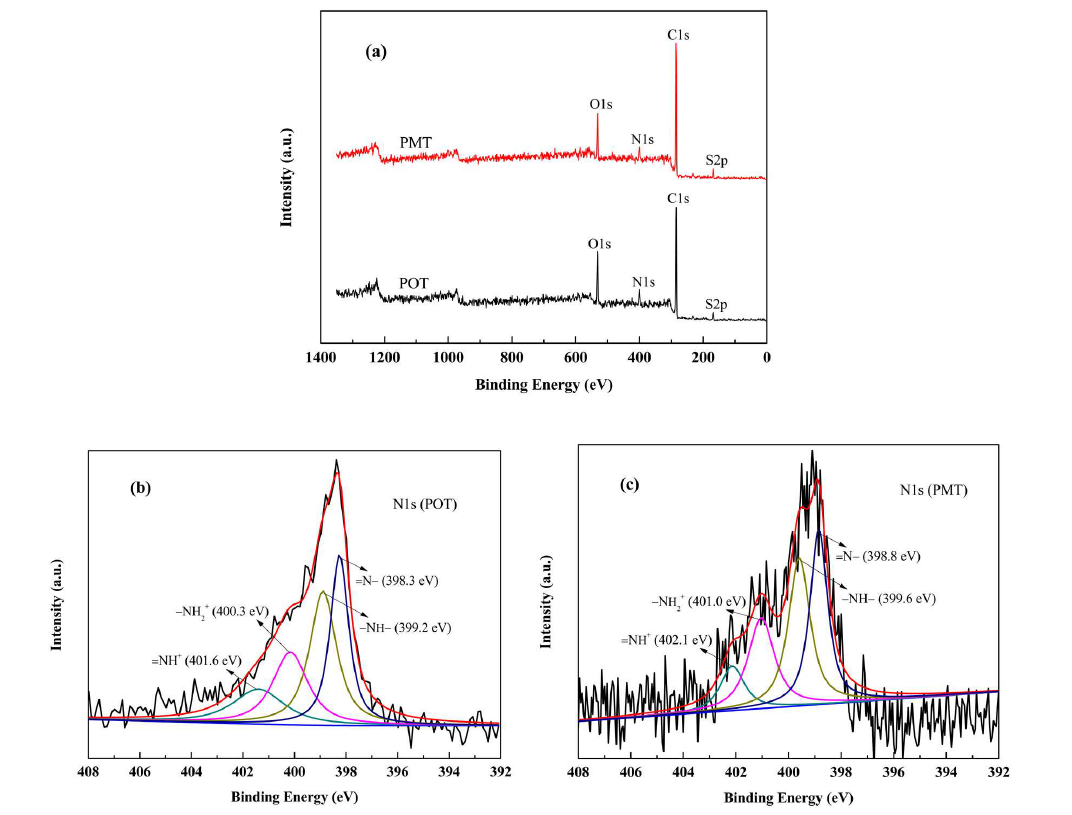
Figure 3. X-ray photoelectron spectroscopy (XPS) spectra of ( a ) survey; N 1s peaks of ( b ) POT and ( c ) PMT.